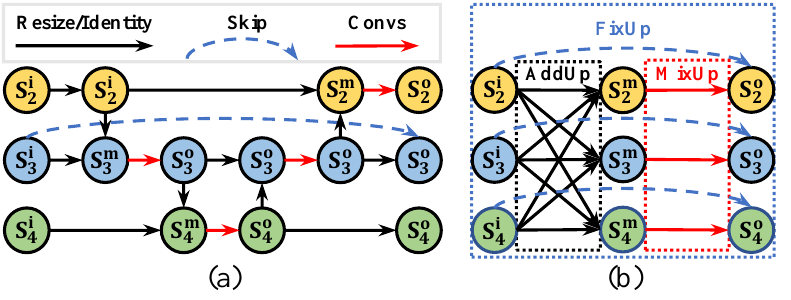
Figure 4. BiFPN vs. MEMe-based TotalFusion. ( a ) the BiFPN, Bidirectional FPN. ( b ) The mutually enhanced TotalFusion. For TotalFusion, the feature pyramid from the backbone is mutually enhanced by AddUp (black), MixUp (red), and FixUp (blue), where ’total’ is the key point compared with BiFPN. As a MEMe-base neck, our TotalFusion shows how to use MEMe to mutually enhance a